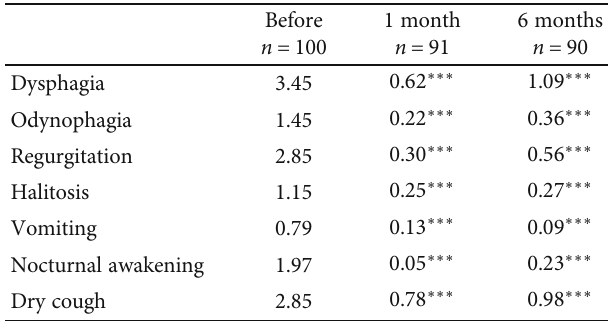
Table 3: Frequency of symptoms of all patients before, one month, and six months after the initial treatment (mean